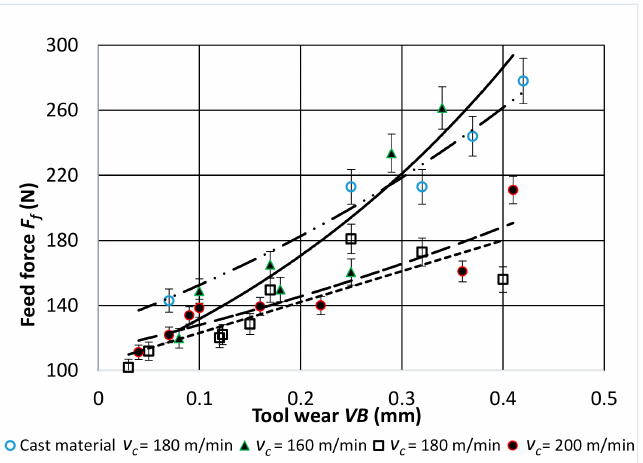
Figure 10. Characteristic of the F f component of the total cutting force as a function of cutting edge wear VB for: f = 0.048 mm/rev; a p = 0.5 mm.